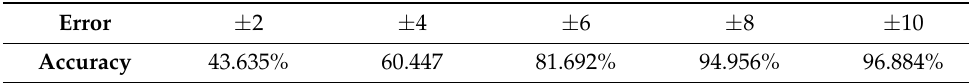
Table 6. Estimation accuracy of ATC